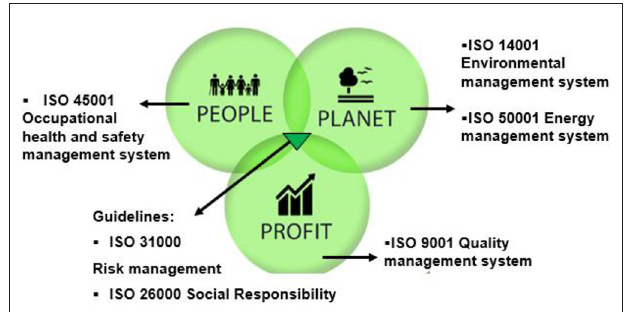
FIGURE 1 | Relationship of ISO Certifiable Management Systems with the TBL. Source: Based on Nunhes et al.